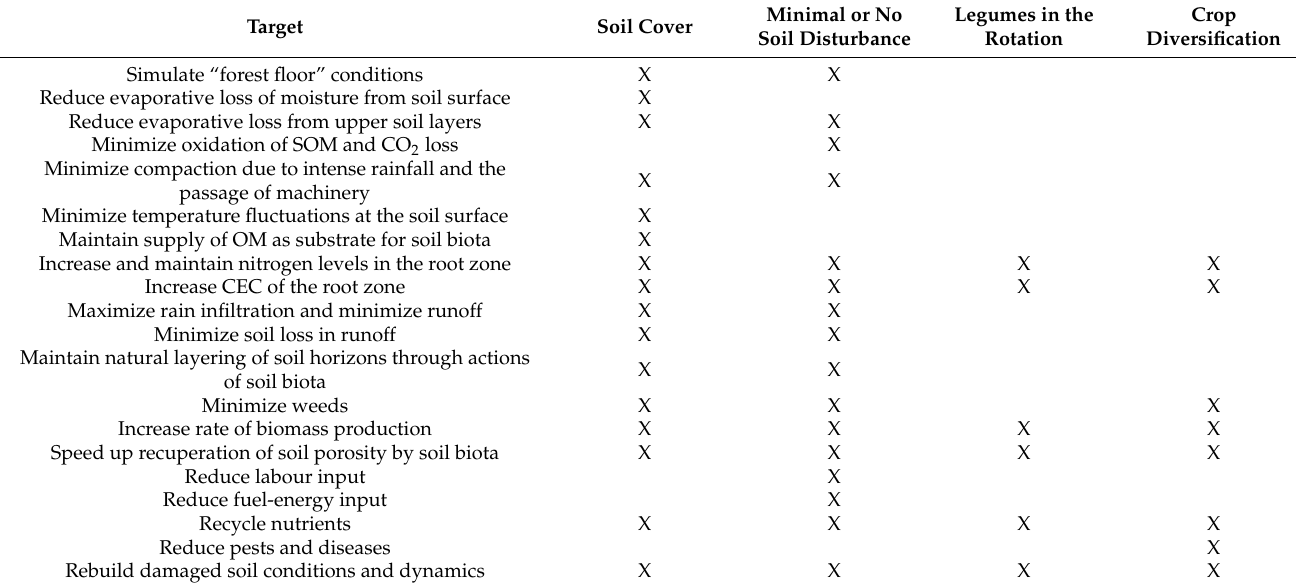
Table 1. Benefits of conservation agriculture [9].